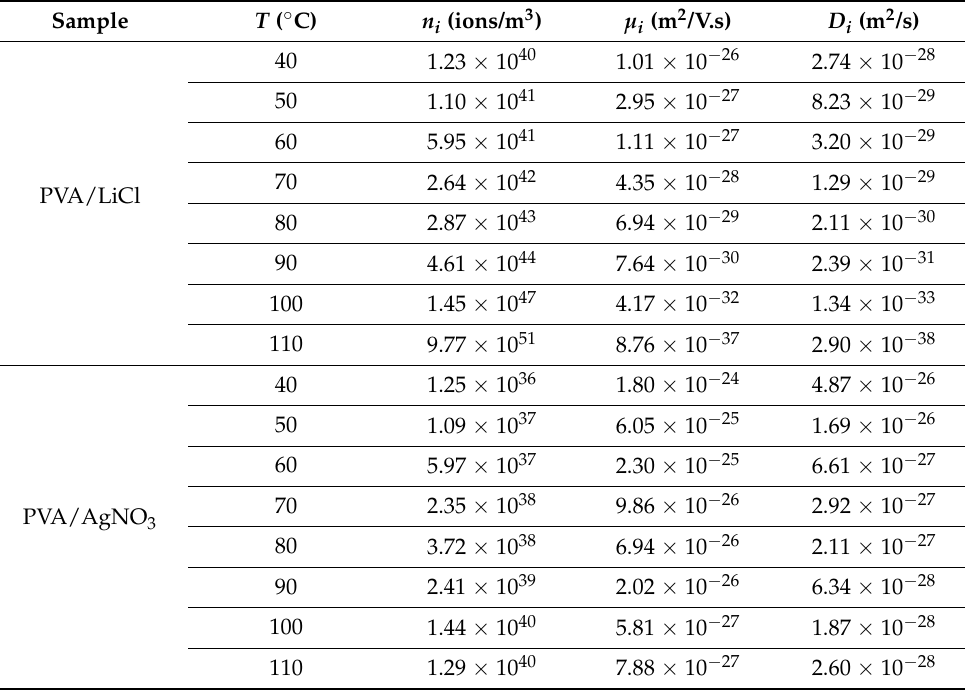
Figure 9. The log N i ( a ), log µ i ( b ) and log D i ( c ) for PVA/AgNO 3 films as a function of temperature. Table 3. n i , µ and D i at different temperatures for the